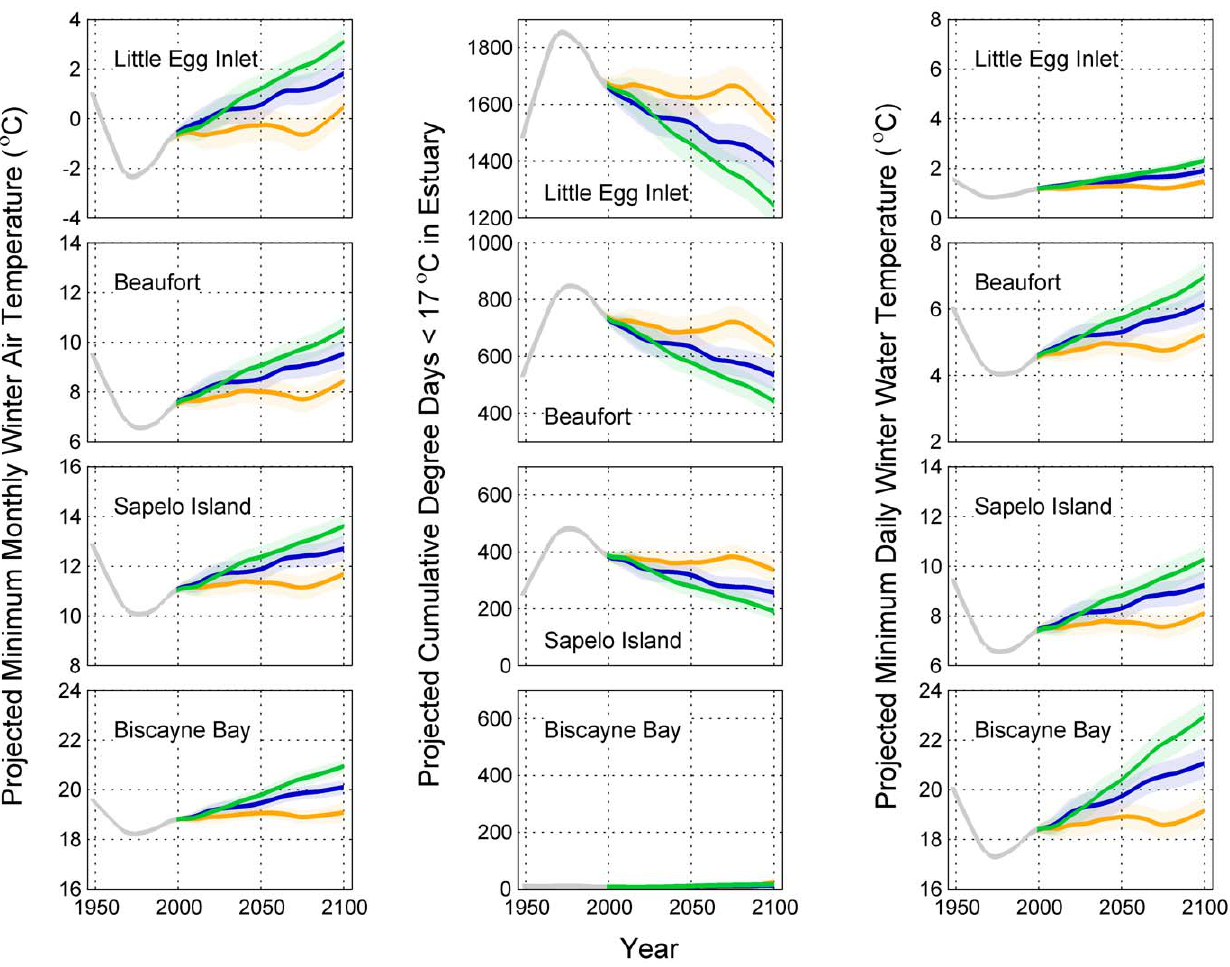
Figure 3. Projections of winter temperature metrics at four estuaries along the east coast of the United States (metrics: minimum mean monthly winter air temperature, cumulative degree days , 17 6 C, and minimum daily estuarine water temperature). Gray line represents observations, orange line represents projections under the commit scenario (350 ppm CO 2 by 2100), blue line represents projections under the B1 scenario (550 ppm CO 2 by 2100), and the green line represents projections under the A1B scenario (720 ppm CO 2 by 2100). A 40 year LOWESS filter (tension=0.25) of the mean annual projections from 14 general circulation models is displayed (see Table 1). Shading represents standard error around mean. Observed and projected thermal tolerance metrics were blended over the period 2001 to 2010; the blended value in 2005 is 0.5 * observed + 0.5 * projected.